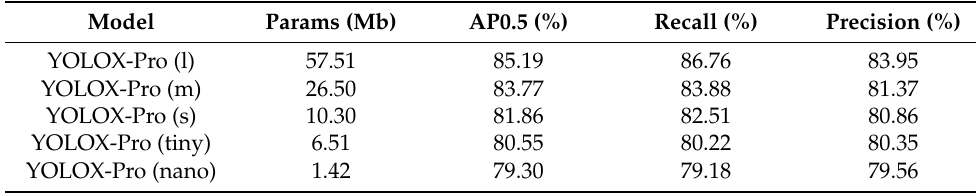
Table 7. Results of the YOLOX-Pro network for detecting the Mibei area.